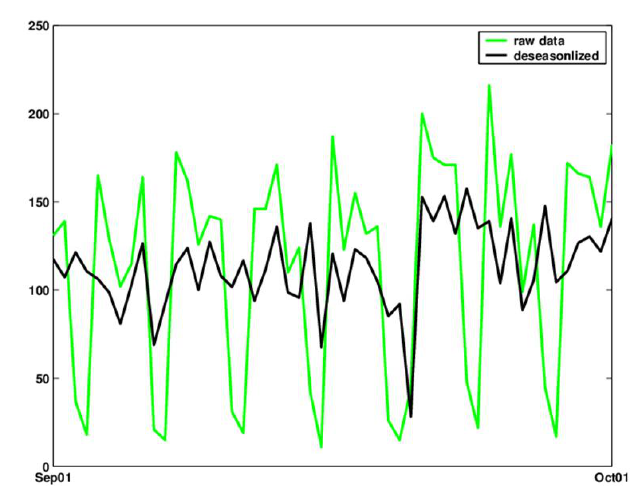
Figure 8. Raw counts (green) and deseasonalized (bold black) counts of daily visits during the month of September